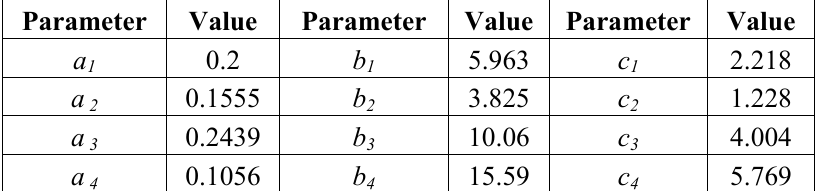
approximation. p